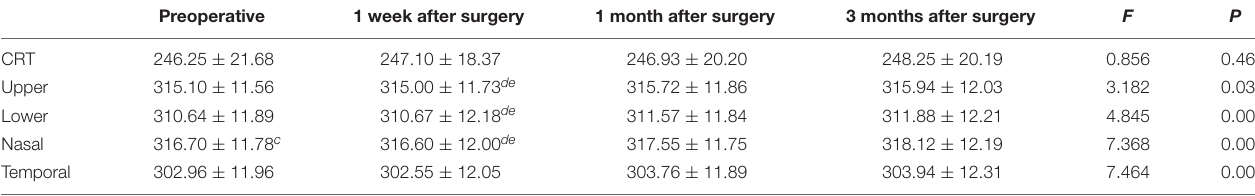
TABLE 2 | Changes of retinal thickness in macular area at each time point.